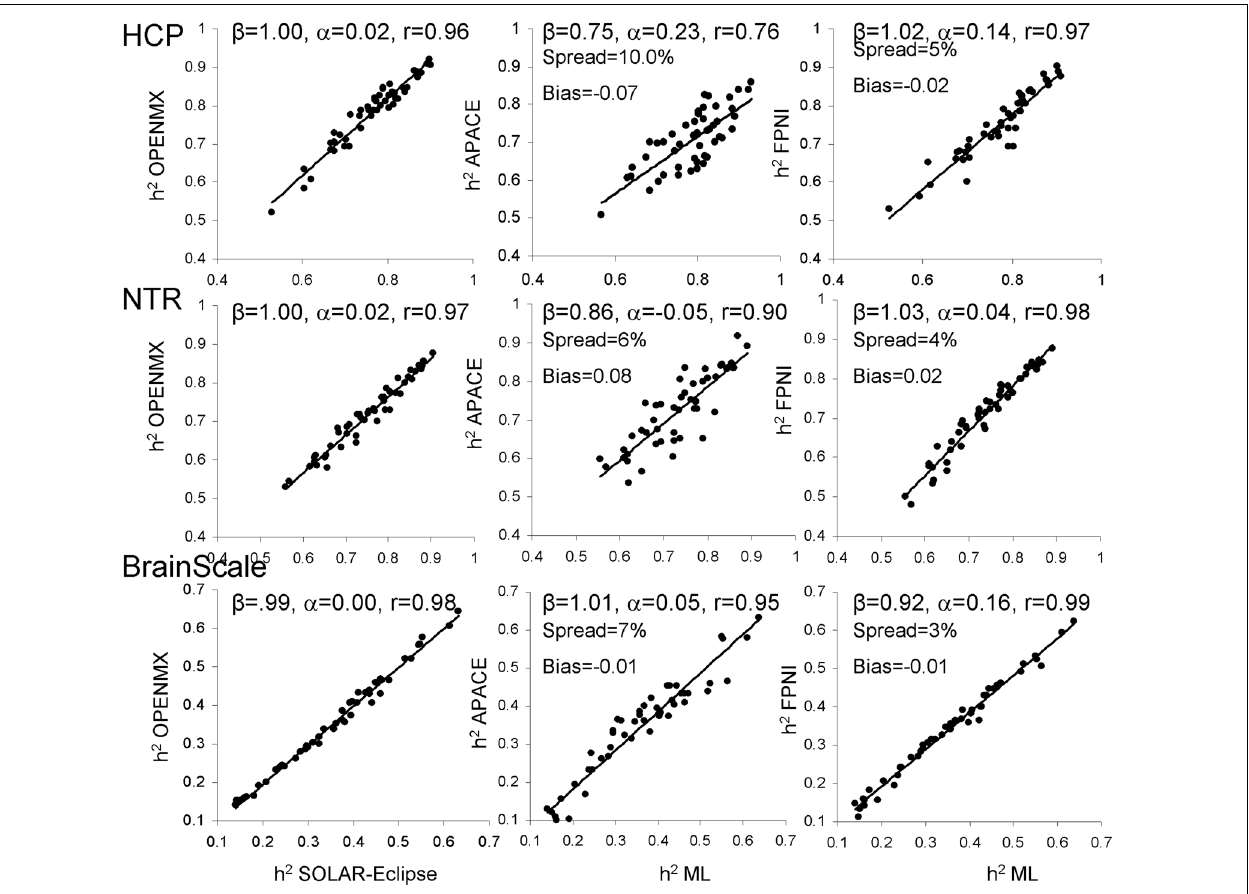
FIGURE 3 | The scatter plot of heritability estimates for 49-regional FA values calculated by ENIGMA-DTI pipeline and then normalized using the trait normalization function in SOLAR-Eclipse. Heritability estimates for two approximation approaches were plotted vs. the average estimate obtained for two ML-based methods: SOLAR-Eclipse and OpenMX. The lines represent linear regression fit vs. ML-based estimates with slope ( β ), intercept ( α ) and Pearson correlation values